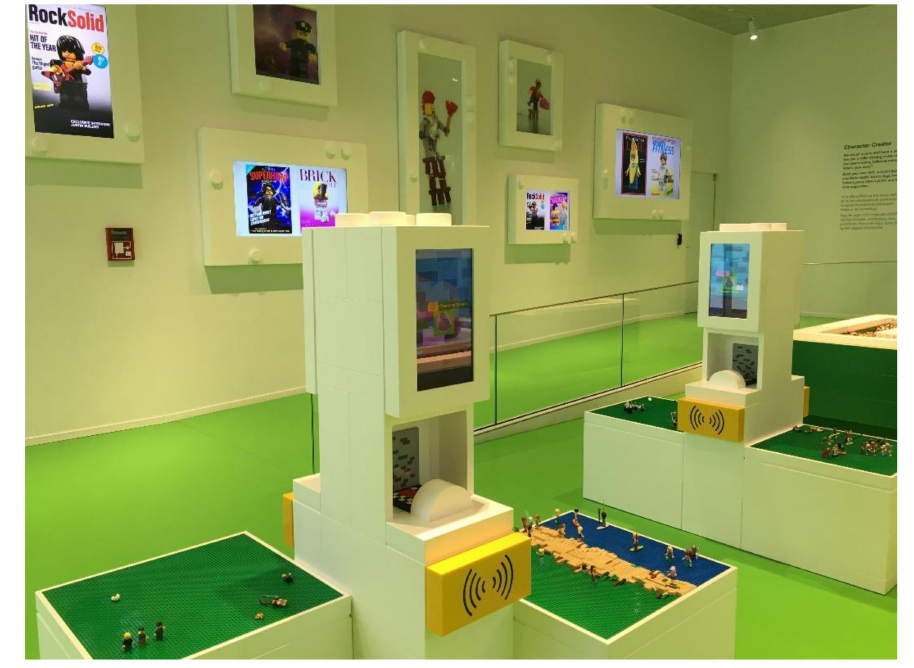
Figure 2. Character Creator capture station.